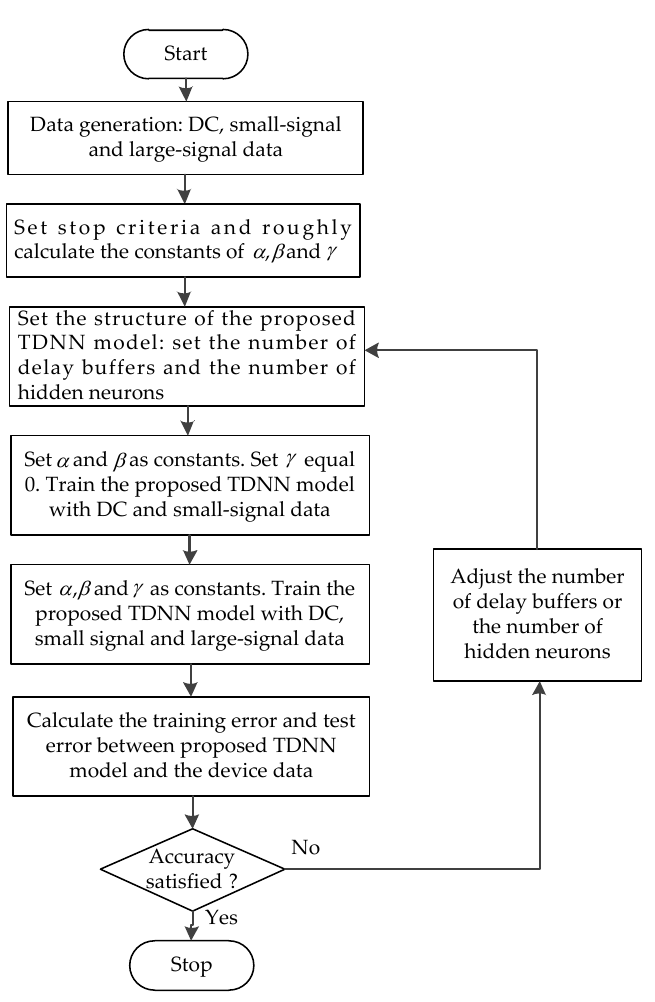
Figure 2. The process for the proposed TDNN model development.